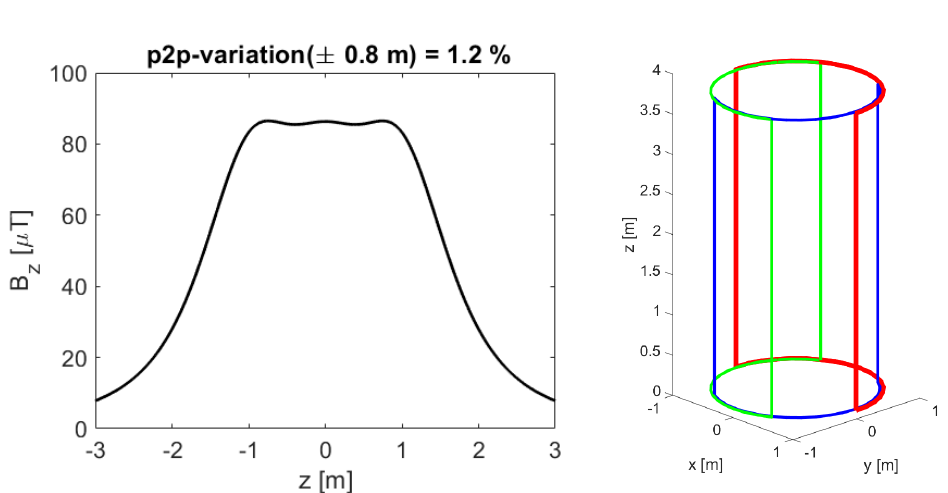
Figure 1. ( Left ): Axial field B z as a function of z . ( Right ): geometry of the three radial coils, shown in red, green, and blue, respectively, each with two vertical wires connected by semi-circular arcs on both